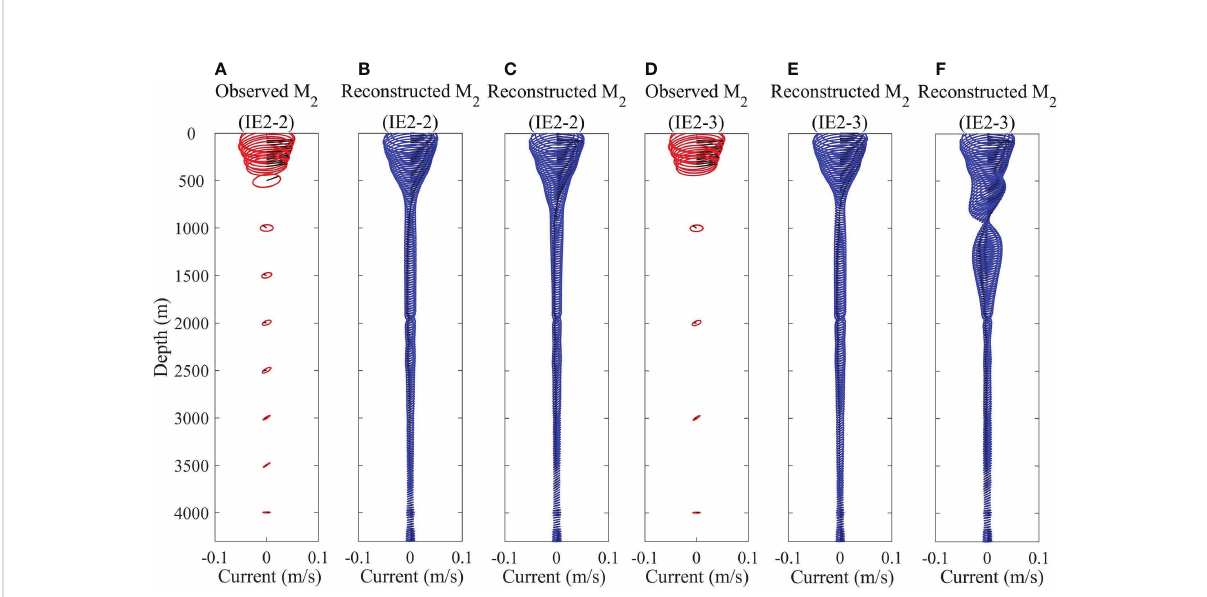
FIGURE 9 (A, D) Observed and (B, C, E, F) reconstructed M 2 tidal currents with (B, E) four normal modes and (C, F) ten normal modes in (A – C) IE2-2 and (D – F) IE2-3.